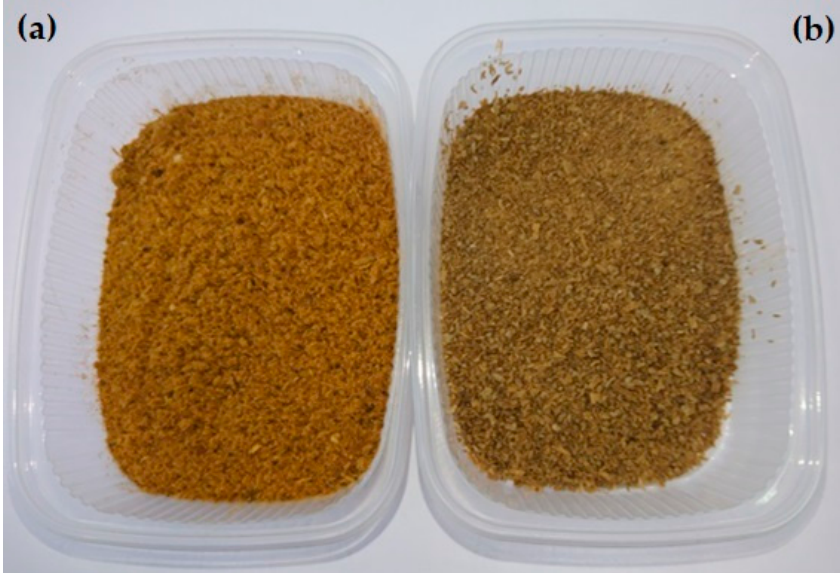
Figure 1. Experimental ingredients used in the canine food. ( a ) Poultry meal; ( b ) insect larvae meal (Photo ©L. Meyer/TiHo). Table 1. Ingredient composition of the basic diet. Ingredient, % as Is Basis